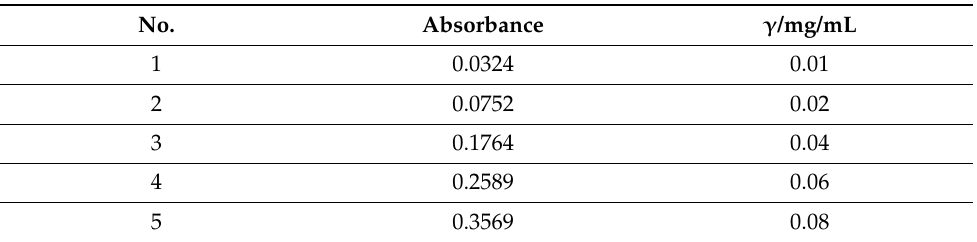
Table 2. Concentrations and the measured absorbance of 5 different solutions of immortelle EO at 265 nm.